Question: Which visualization type does this figure use?
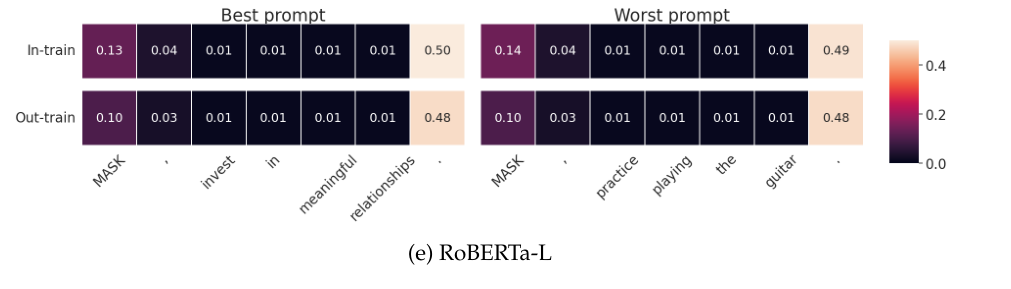
Answer: heatmap